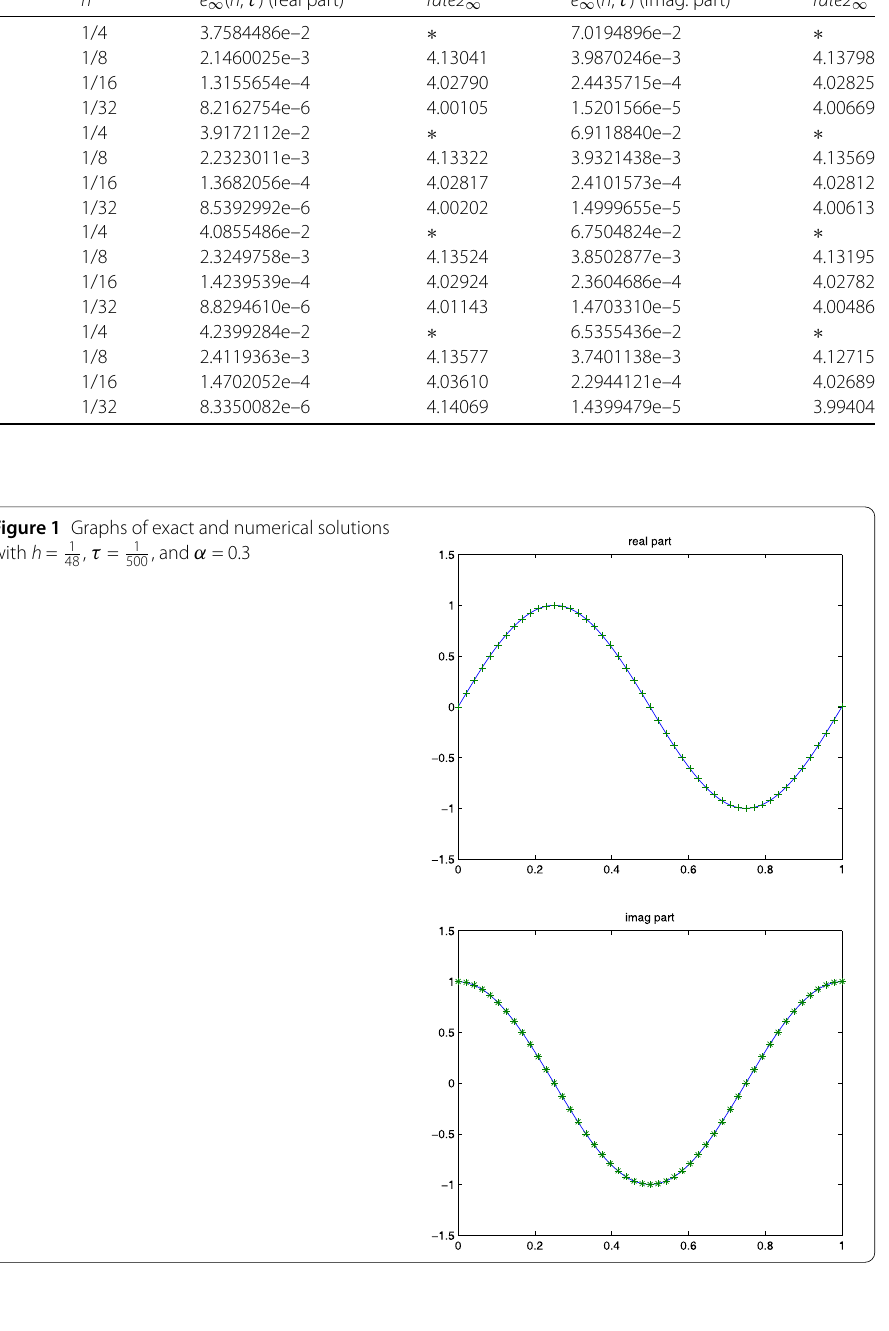
Table 2 The spatial errors and convergence orders with τ = 1